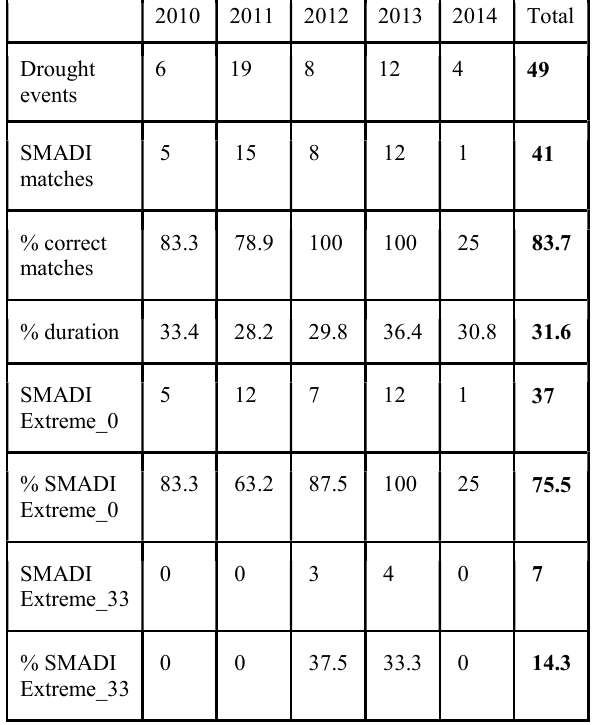
Table 3. Validation results for SMADI.